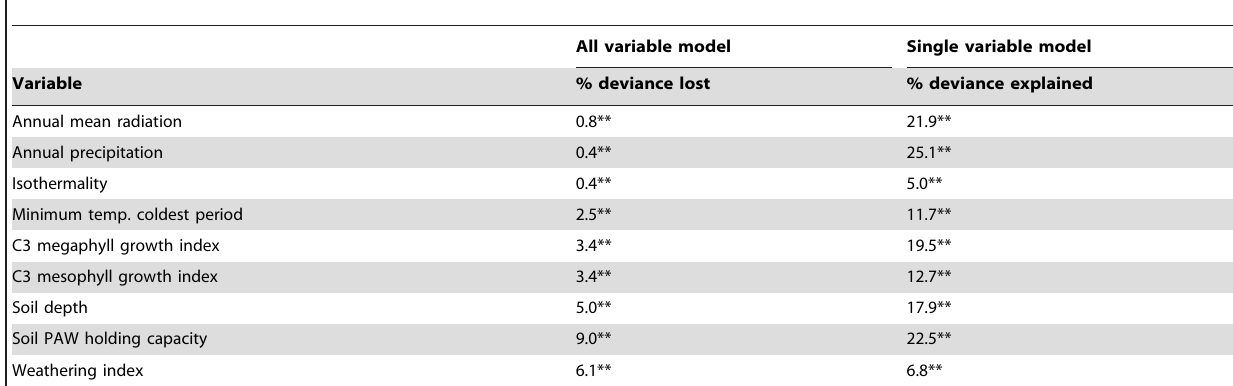
Table 1. Variable contribution to the Generalised Additive Model of plant species richness for the Australian Wet Tropics.